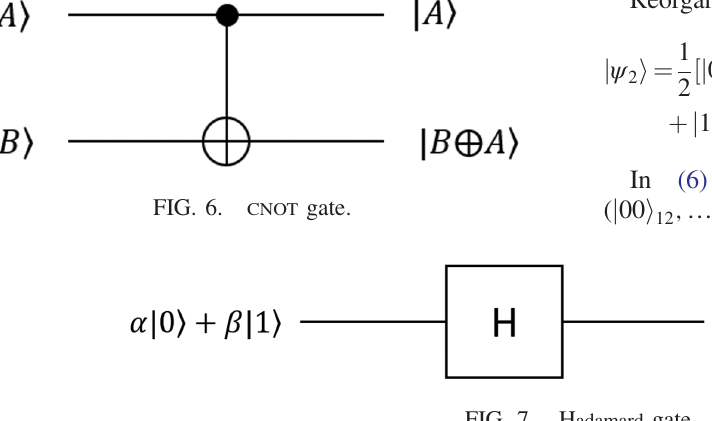
FIG. 7. H adamard